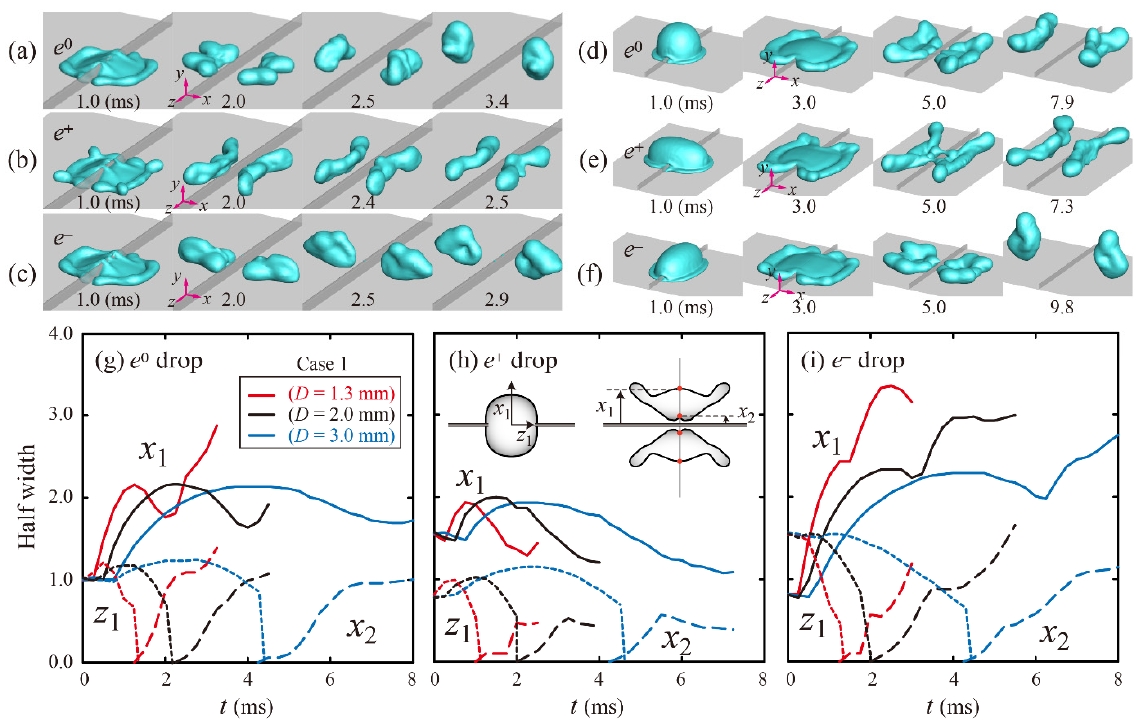
Figure 5. Snapshots of water drops of Case 1 with ( a – c ) D = 1.3 mm and ( d – f ) 3.0 mm at We = 47. ( g – i ) Temporal variations in dimensionless half widths of e 0 , e + , and e − drops until drops rebound from the surface and ridge.